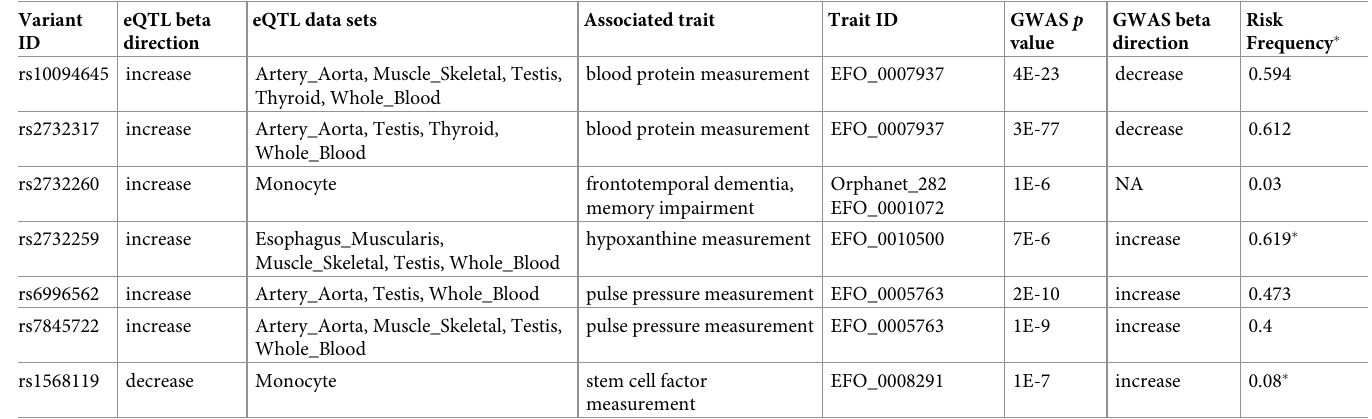
Table 4. Human genomic variants with overlapping associations to TTI2 expression and